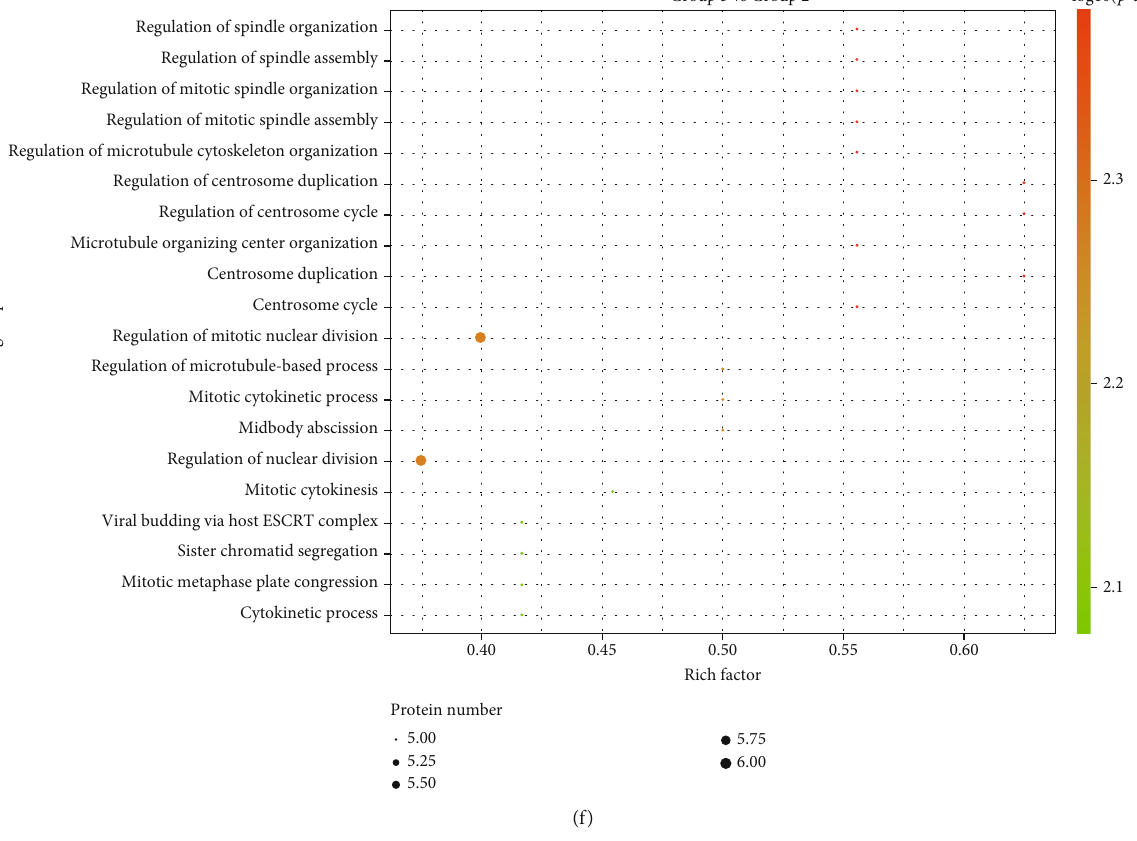
Figure 3: Functional enrichment analysis of signaling pathways and biological process of DEGs. A comparison of top 20 Gene Ontology terms of signaling pathways (a, c, e) and biological process (b, d, f) is indicated among groups (group 1: healthy controls, group 2: inactive JSLE patients, and group 3: active JSLE